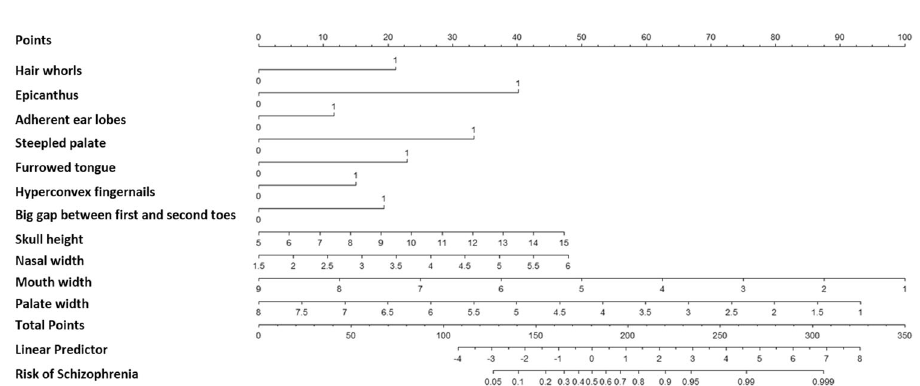
Fig. 1 Nomogram of logistic regression analysis. A 11-variable nomogram established by logistic regression for predicting the risk of schizophrenia using minor physical anomalies.